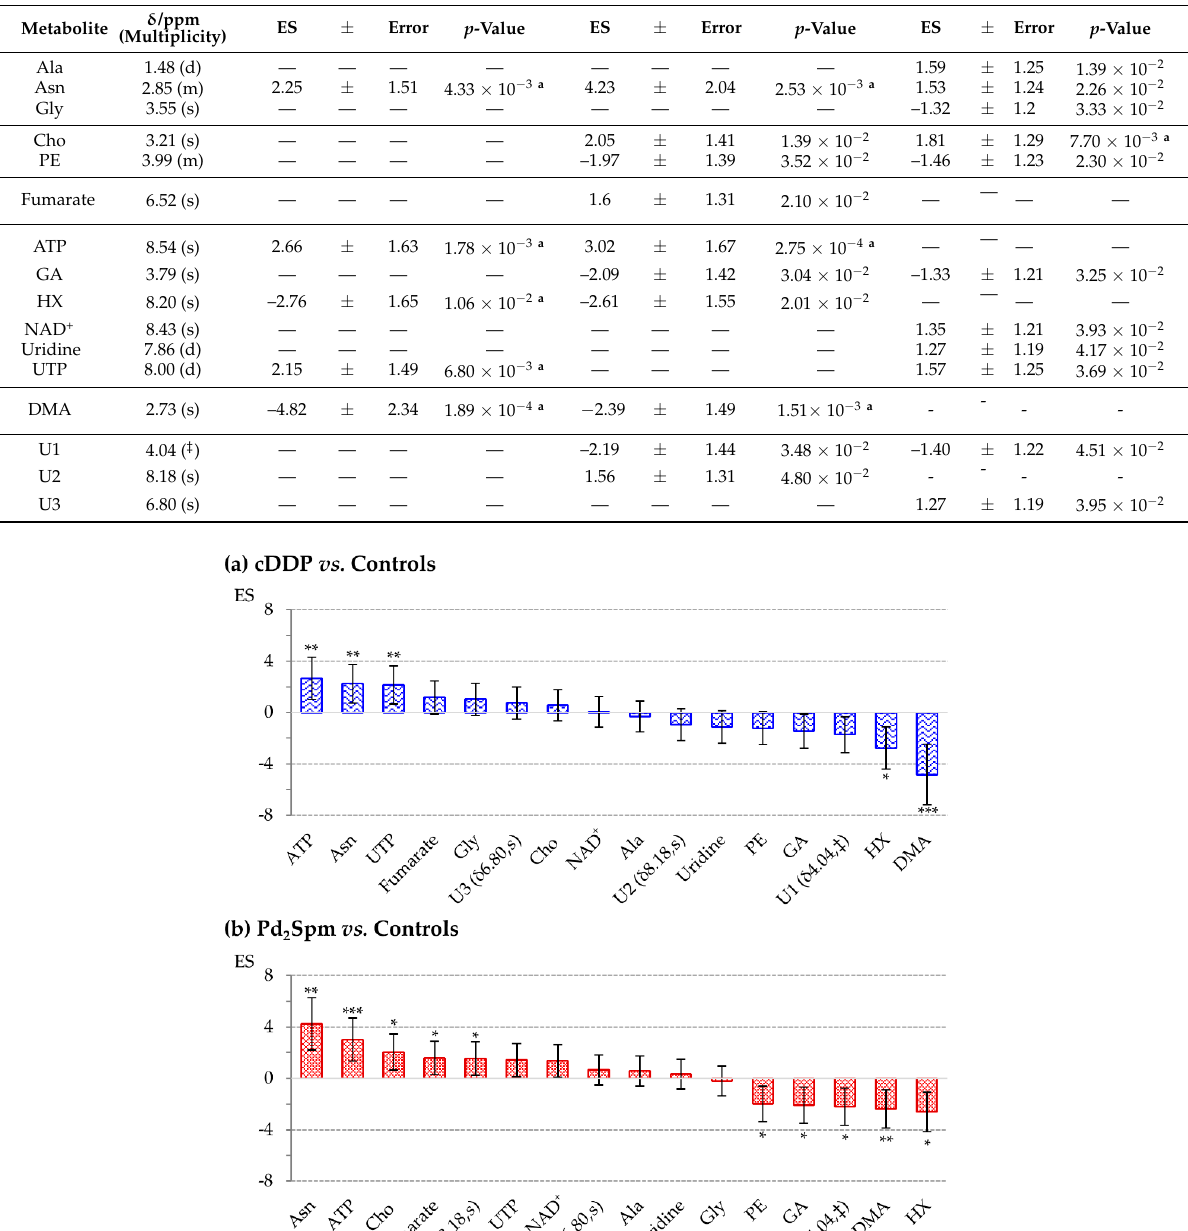
Table 1. Univariate analysis of the polar metabolome of tumors from the MDA-MD-231 CDX mouse model exposed to cDDP and Pd 2 Spm, with comparisons shown (i) for each drug vs. controls, and (ii) between drugs. The metabolite variations selected exhibit |Effect size (ES)| > Error [74], and p -value < 0.05. ‡ Partial integration of peak. a Metabolic variations that remain statistically significant after false discovery rate correction [75]. Metabolite abbreviations: Int., intermediates; NAD + , nicotinamide adenine dinucleotide (reduced); Ui, unassigned resonance i; other abbreviations as defined in the captions of Figures 1 and 3. Multiplicity abbreviations: s, singlet; d, doublet; m, multiplet. cDDP vs. Ctr Pd 2 Spm vs. Ctr